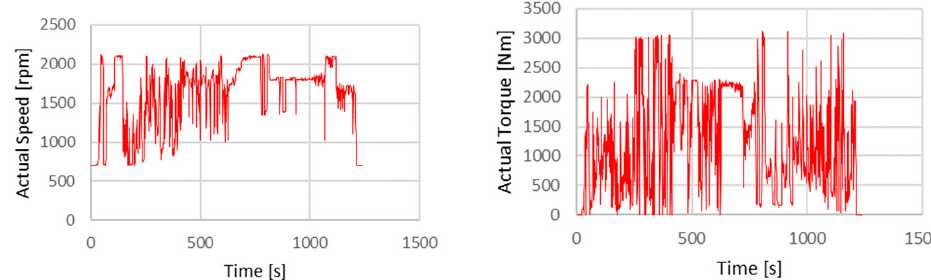
Figure 2. NRTC: Actual Speed; Actual Torque.